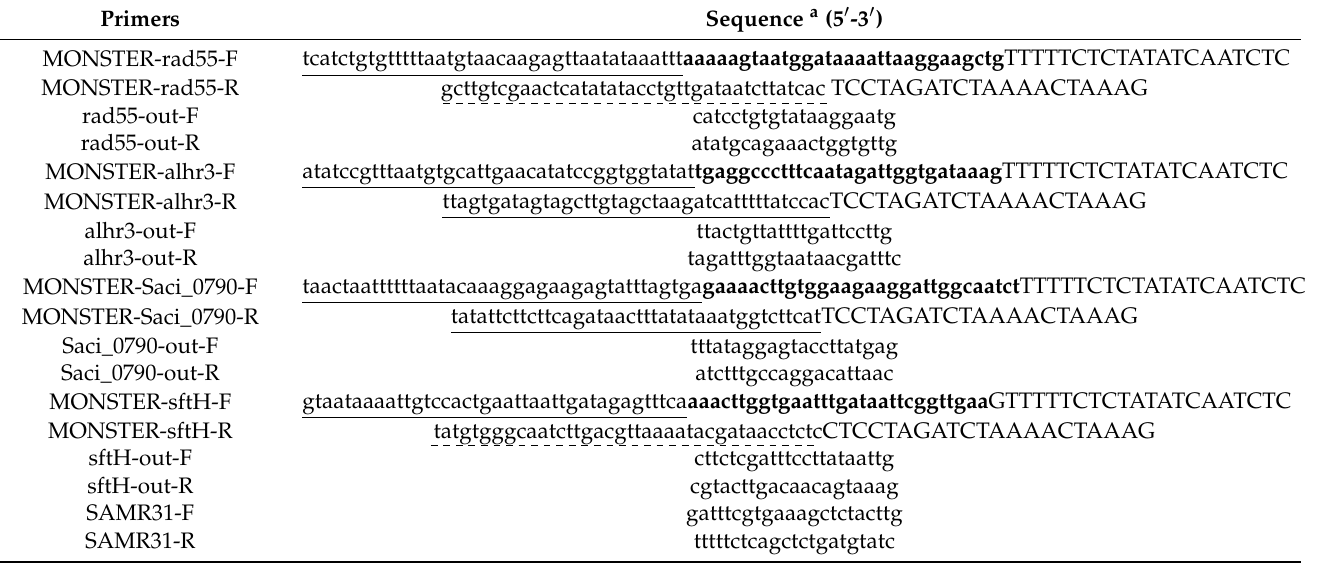
Table 3. Primers used in this